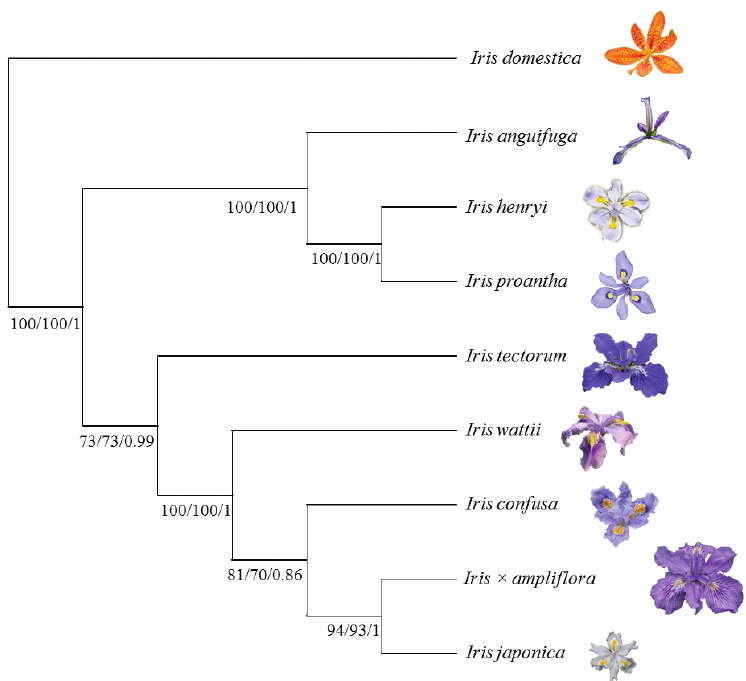
Figure 3. Phylogenetic relationships of Iris × ampliflora based on two plastid DNA fragments. Numbers around nodes are Bayesian posterior probabilities and bootstrap percentages (PP /BS of flowers are relatively proportional sizes among different Iris species).